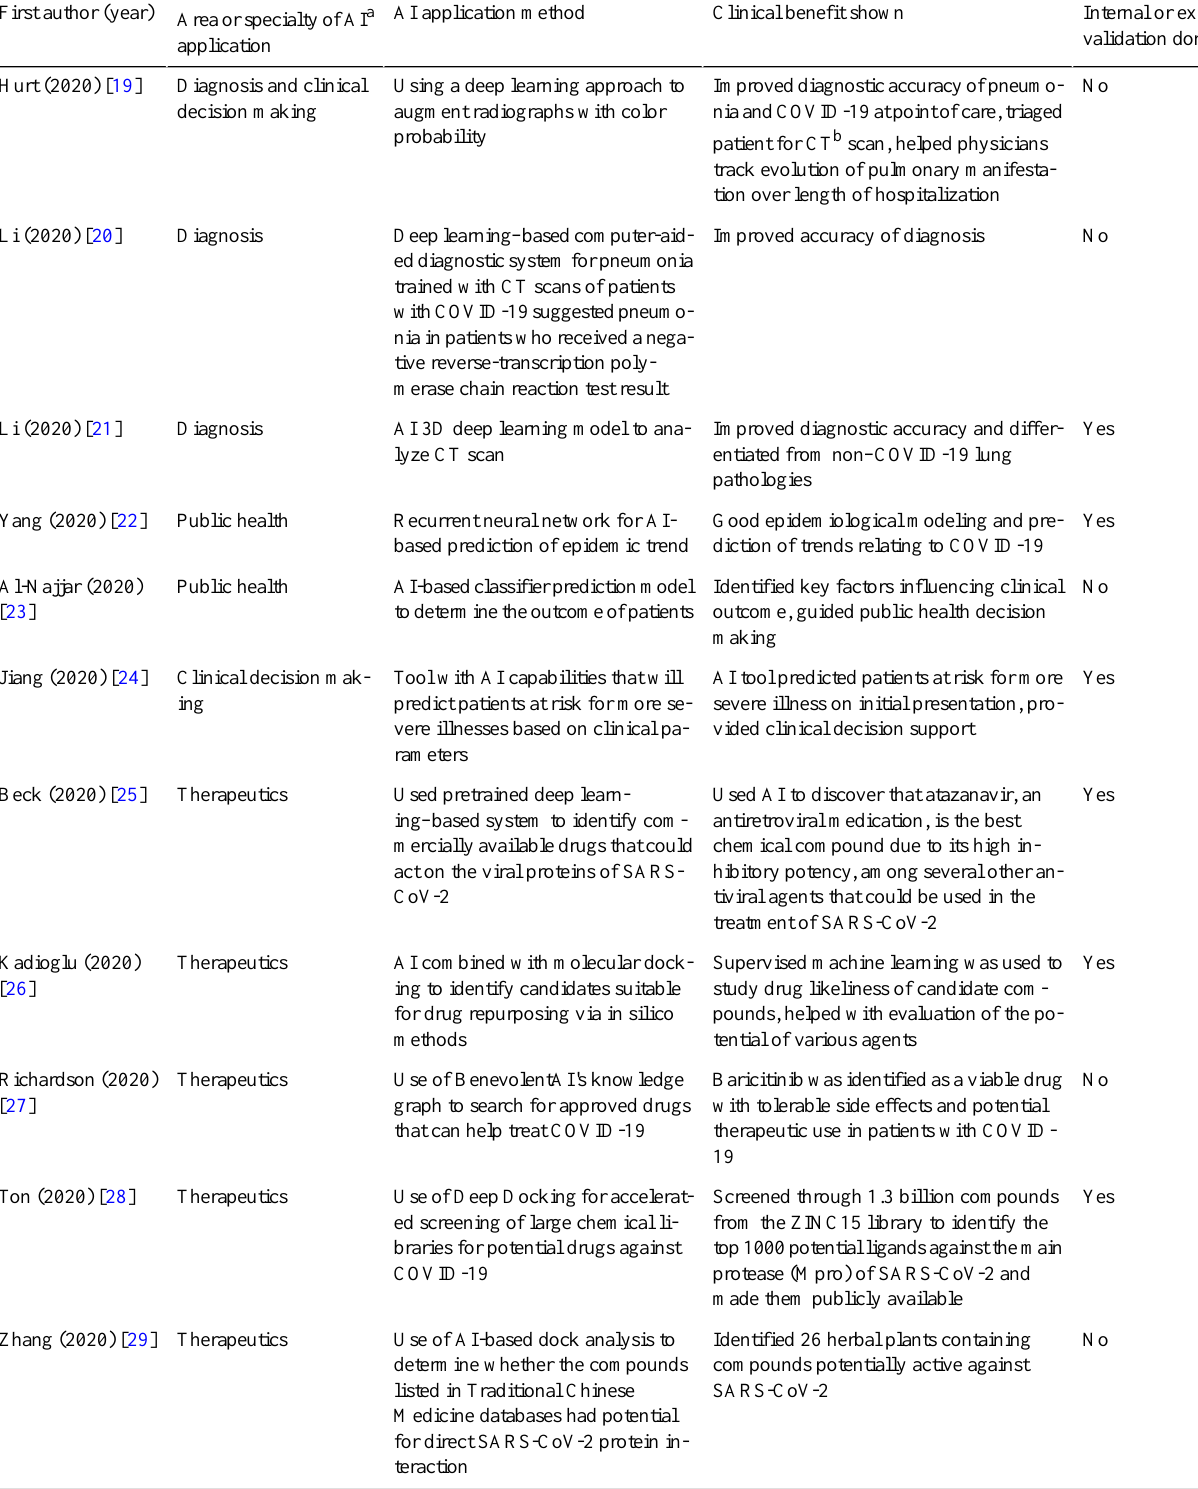
Table 1. Studies included in the review.